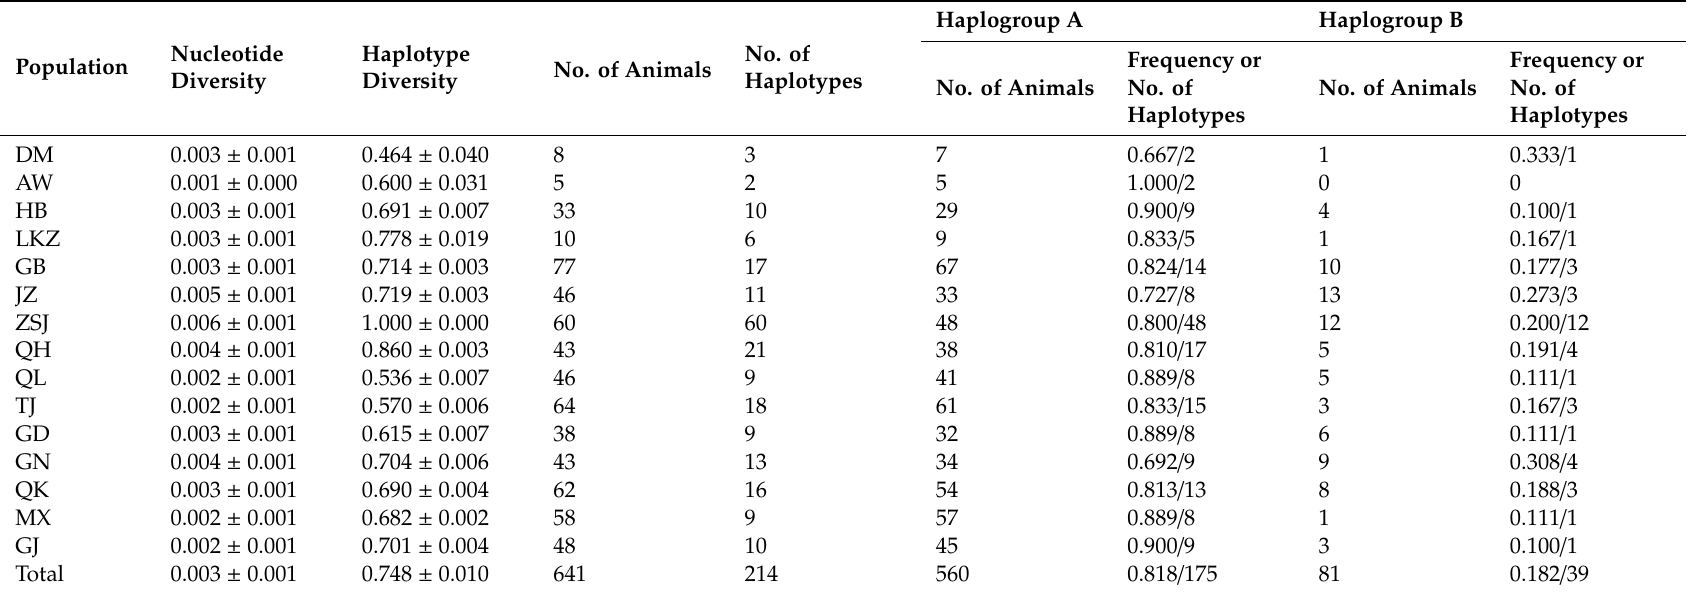
Table 1. Genetic diversity indices for 15 populations of indigenous Tibetan